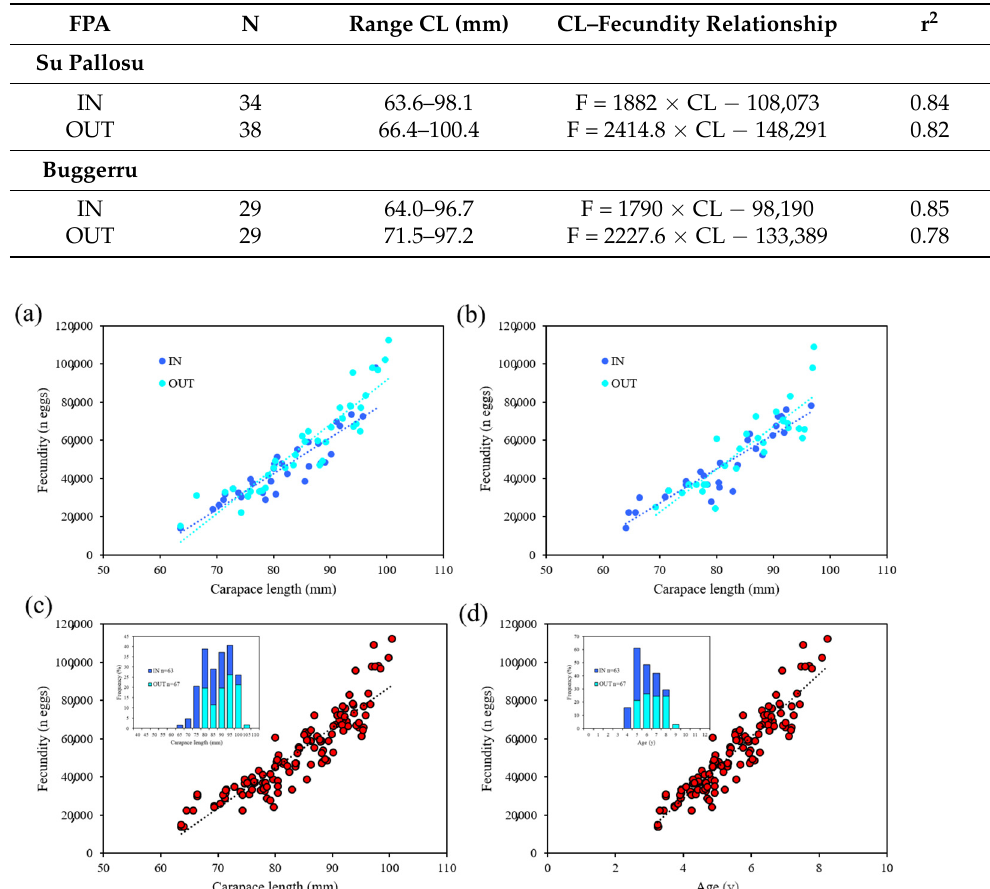
Figure 2. Number of eggs per body gram against Carapace length and fitted line for females Palinurus elephas . Equation of fitted line is given in the text. Table 2. Number and size ranges of berried females analysed for fecundity estimation calculated for the two Su Pallosu and Buggerru FPAs, separately, and their surrounding fishing areas.